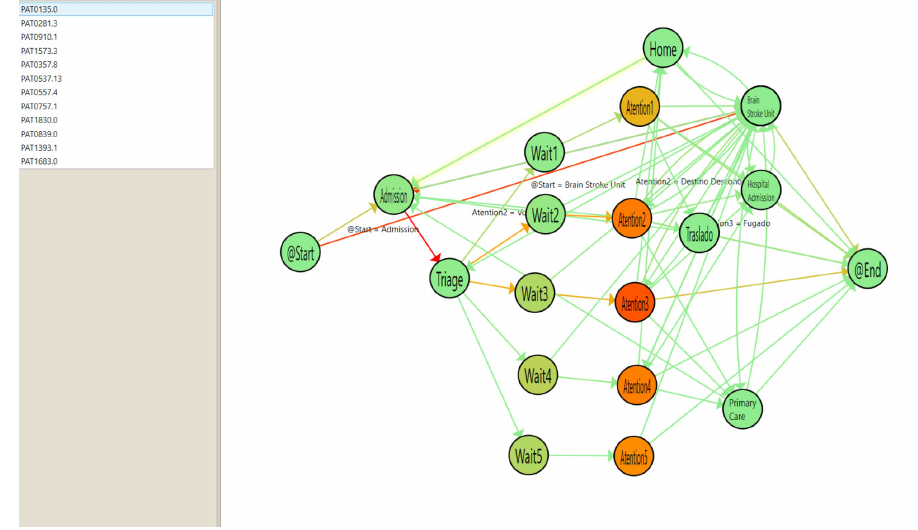
Figure 16. List of patients Readmitted after a Home